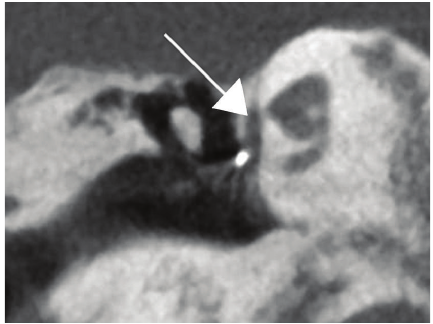
Figure 3: Coronal noncontrast computed tomography of right temporal bone reveals the end of a previously placed stapes prosthesis (metallic object) abutting the second genu of the facial nerve (arrow), which is descending anterior to the promontory as evidenced by its location adjacent to the turns of the